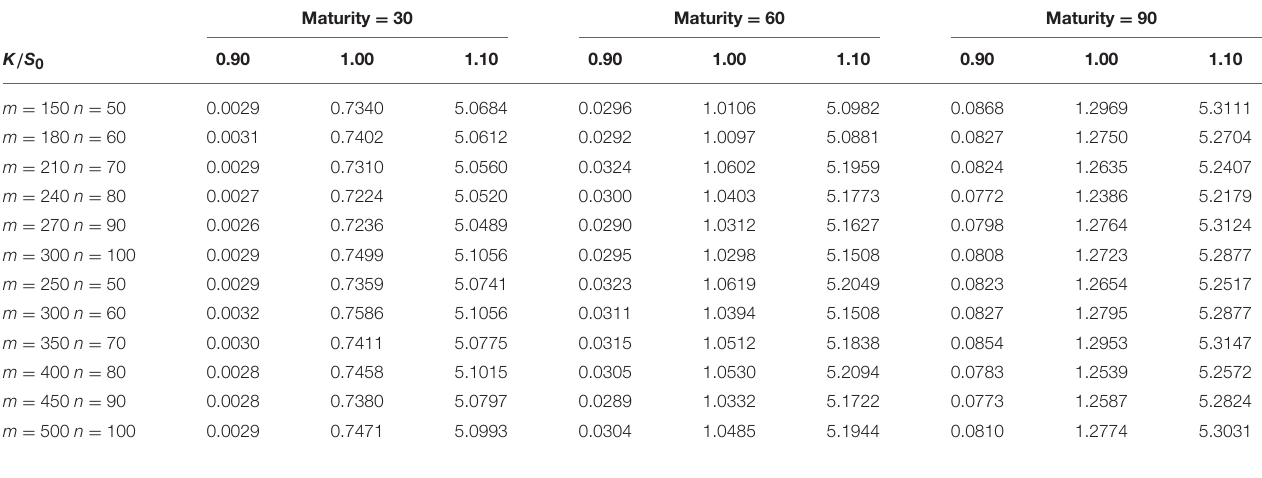
TABLE 3 | American put options in the NTS-GARCH framework.